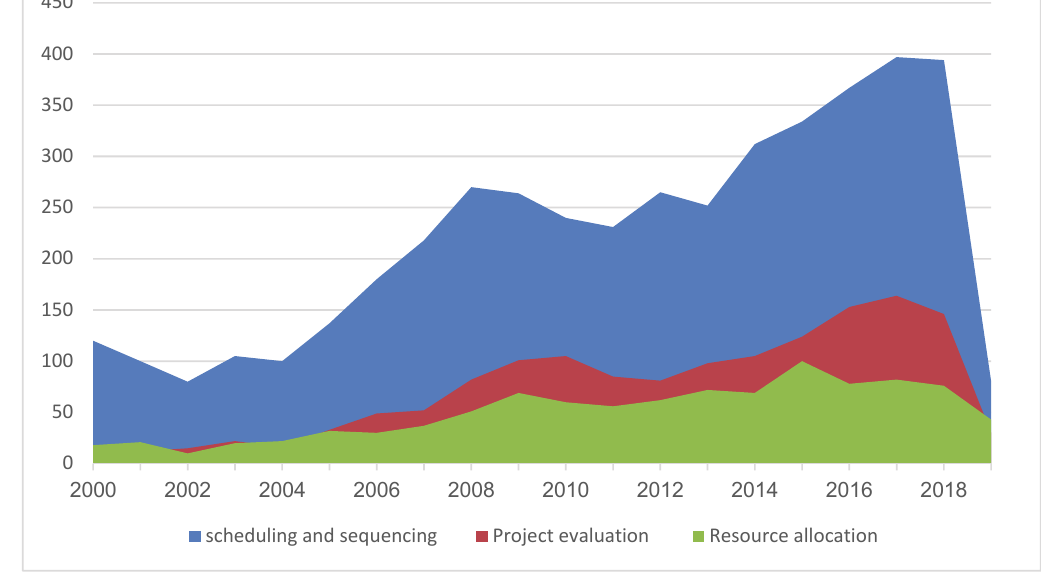
Fig. 2. Related papers published during 2000-2019